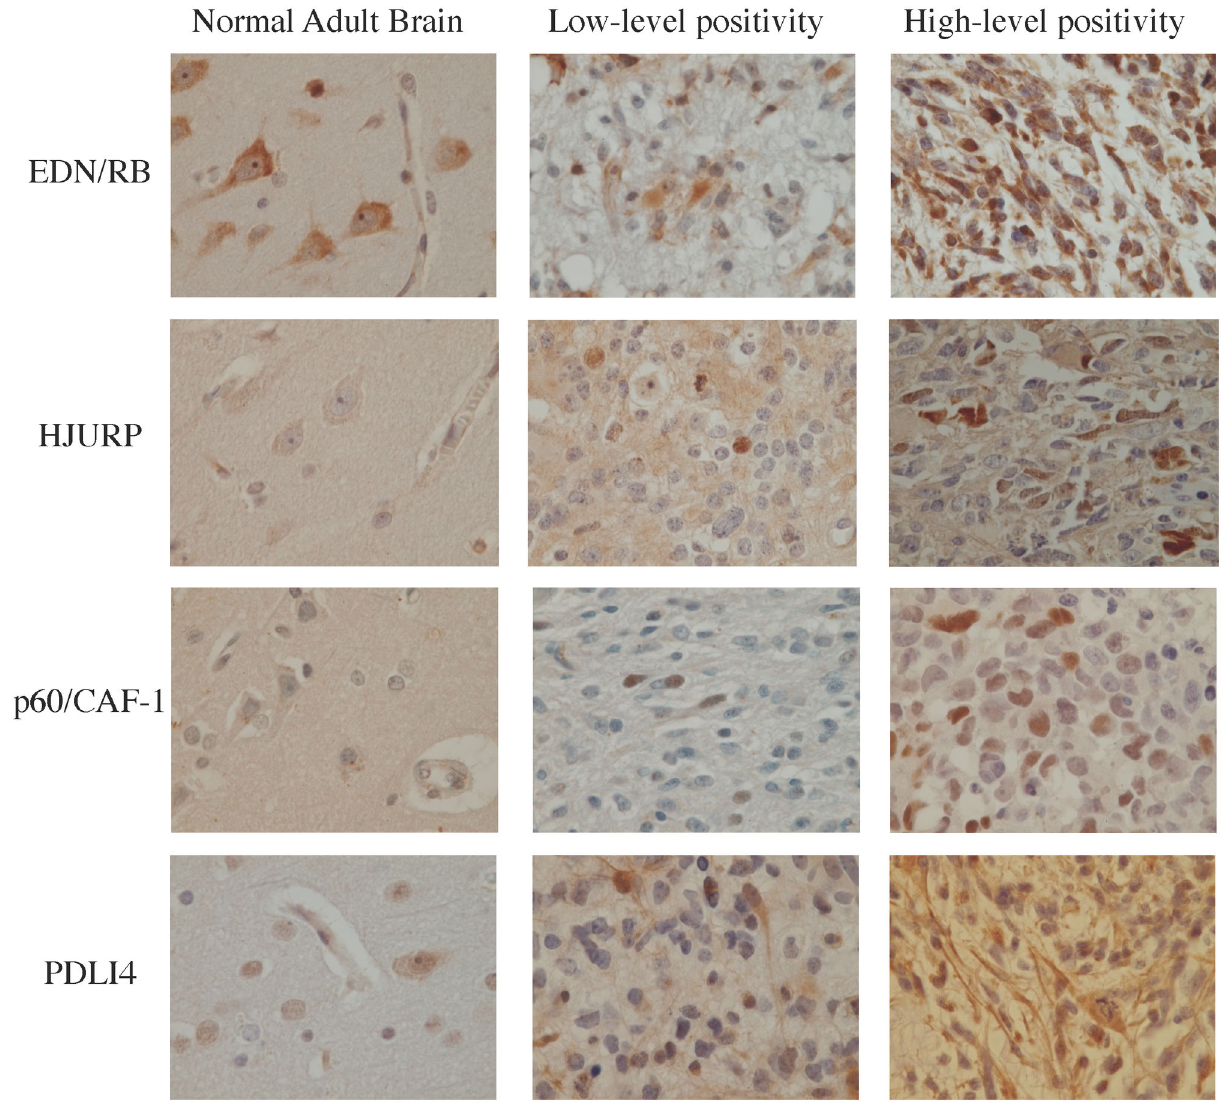
Figure 1. Examples of the range of marker immunopositivity within normal adult brain and high-grade gliomas. Sections of paraffin-embedded specimens from six normal brain tissues and 96 HGG specimens, consisting of WHO grade III and IV glioma samples, were stained by immunohistochemistry with antibodies against EDN/RB, HJURP, p60/CAF-1 and PDLI4. Representative data are reported for each protein: a section of normal adult brain tissue, a section from a weakly positive tumour and a section from a strongly positive tumour. doi: